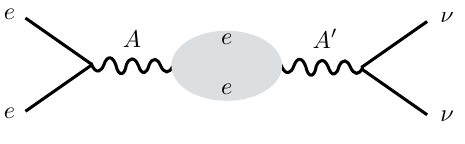
Figure 11 . Neutrino production contributing to white dwarf cooling from hidden photon